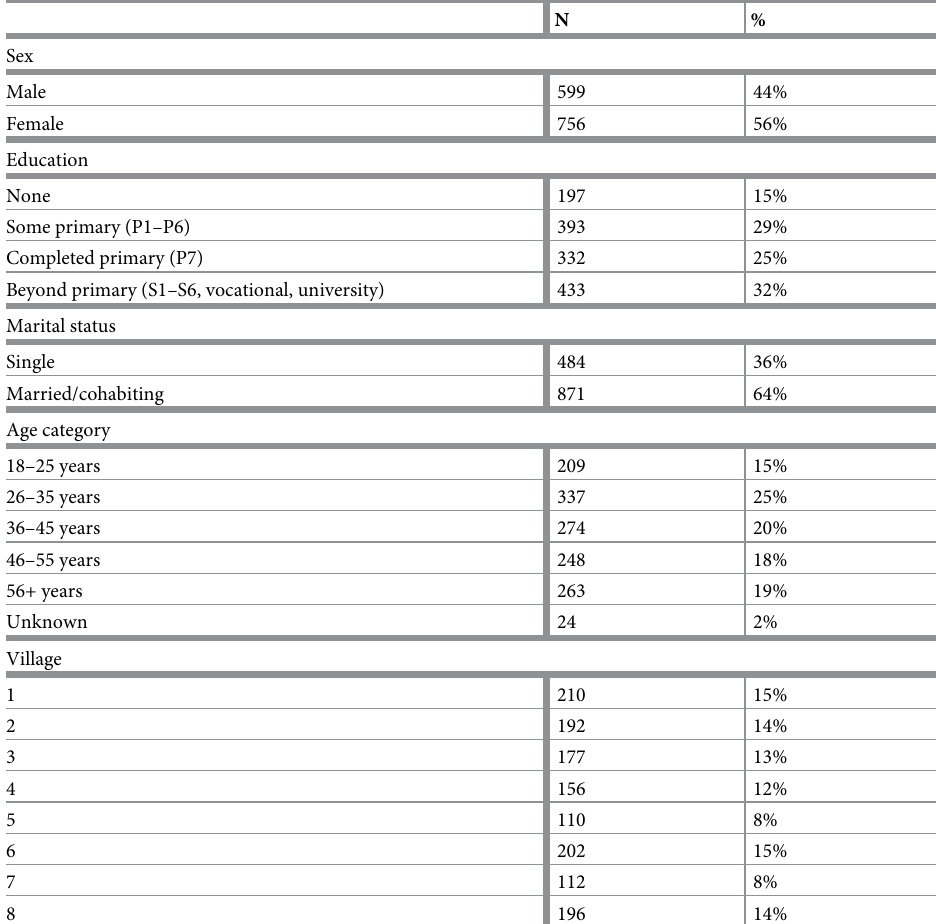
Table 1. Participant